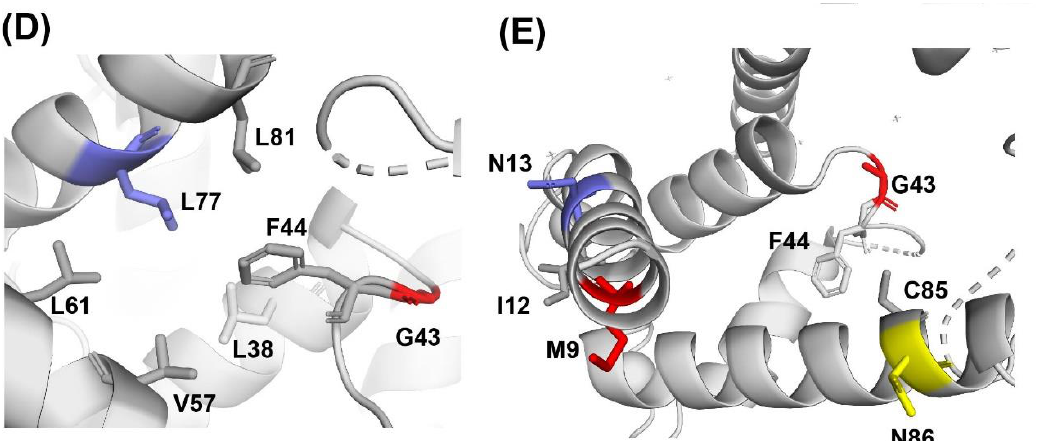
Figure 9. Sequence similarities and differences for S100B and S100A1. ( A ) Sequence alignment and conservation score of S100A1 and S100B calculated in JalView [51,52]. Columns with conserved residues are indicated by ‘*’, columns with residue changes where all properties are conserved are indicated by ‘+’, while columns with residue changes are marked with values ranging from ‘9’ to ‘4’ depending on the physiochemical properties of the changed amino acid residue. ( B ) Colors corresponding to the conservation scores were mapped onto a surface diagram of Ca 2+ -S100B (4PE0). Residues specific for S100B (scored 4–9) within Sites 1–3 are labeled. Sites 1, 2 and 3 are shown in dashed circles in green, yellow and copper, respectively. ( C ) Ribbon diagram of Site 3 of Ca 2+ -S100B (4PE0) with Site 3 residues shown in sticks. ( D ) Ribbon diagram of G43 and F44 in Ca 2+ -S100A1 (5K89) and ( E ) Ca 2+ -S100A1 amino acid residues corresponding to Site 3 of S100B shown in sticks. Colors correspond to the residue conservation score in ( A ).